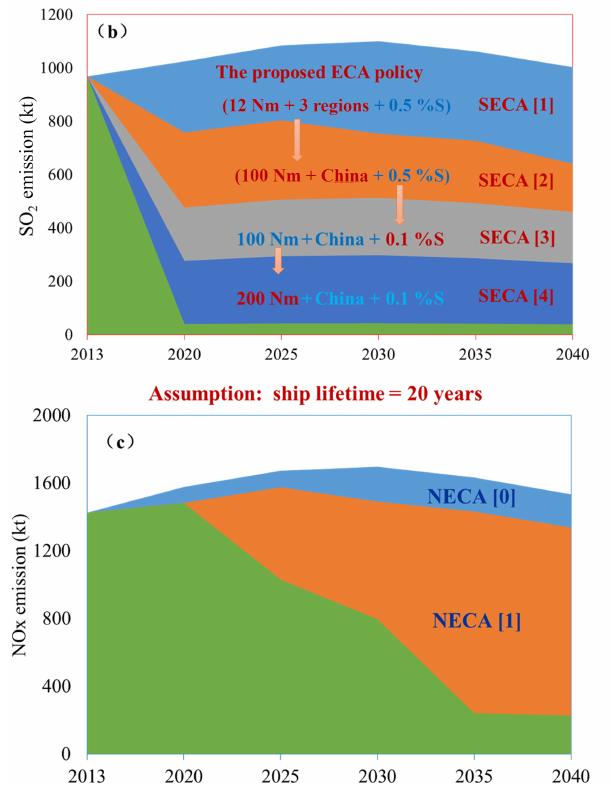
Figure 8. SO 2 and NO x emissions from the shipping sector under SO 2 DECA (a, b) and NO x DECA (c) with different control poli- cies from 2013 to